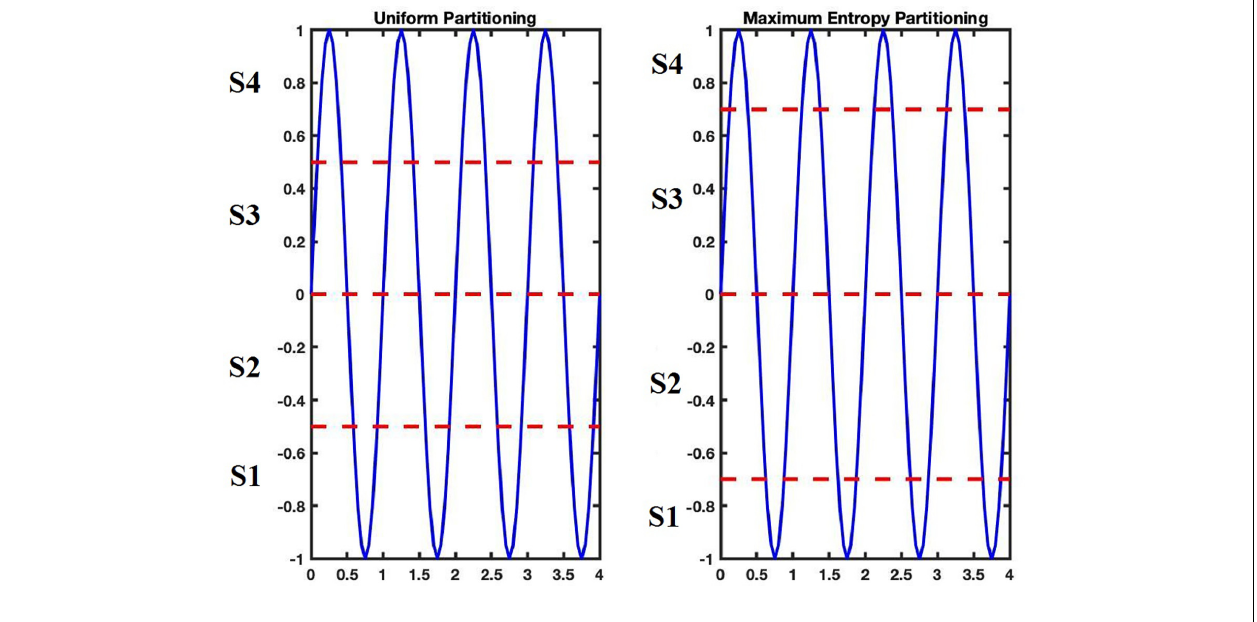
FIGURE 4 | Uniform and Maximum Entropy (ME) partitioning examples with S = 4.